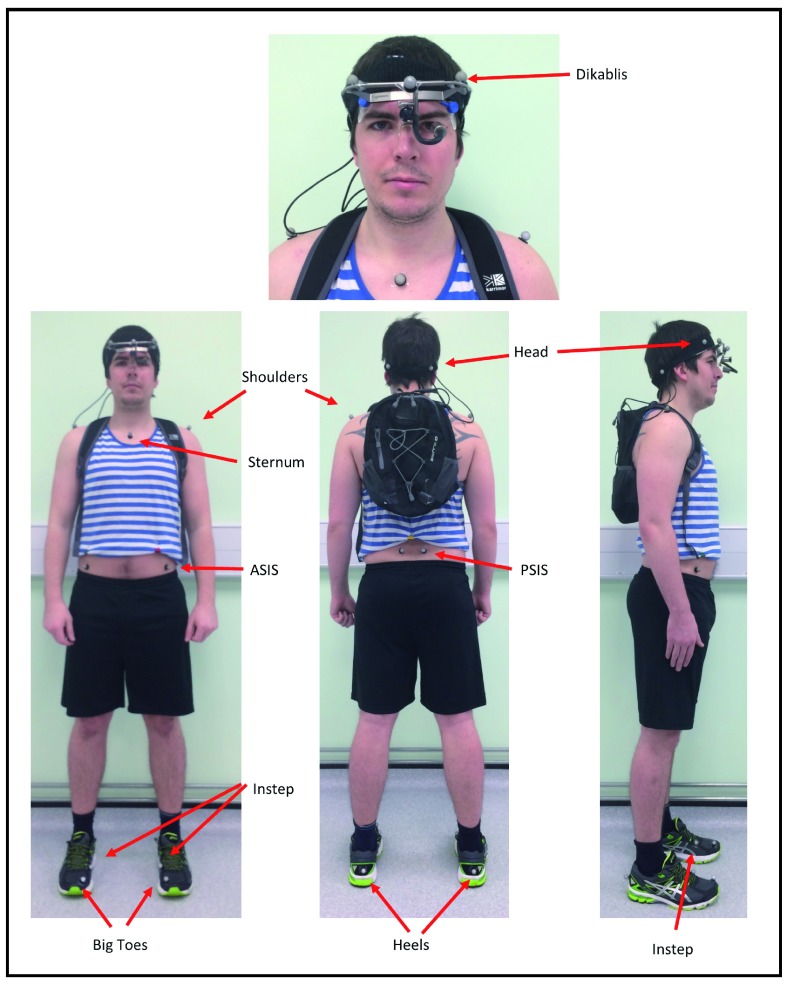
Reflective marker body placement locations.